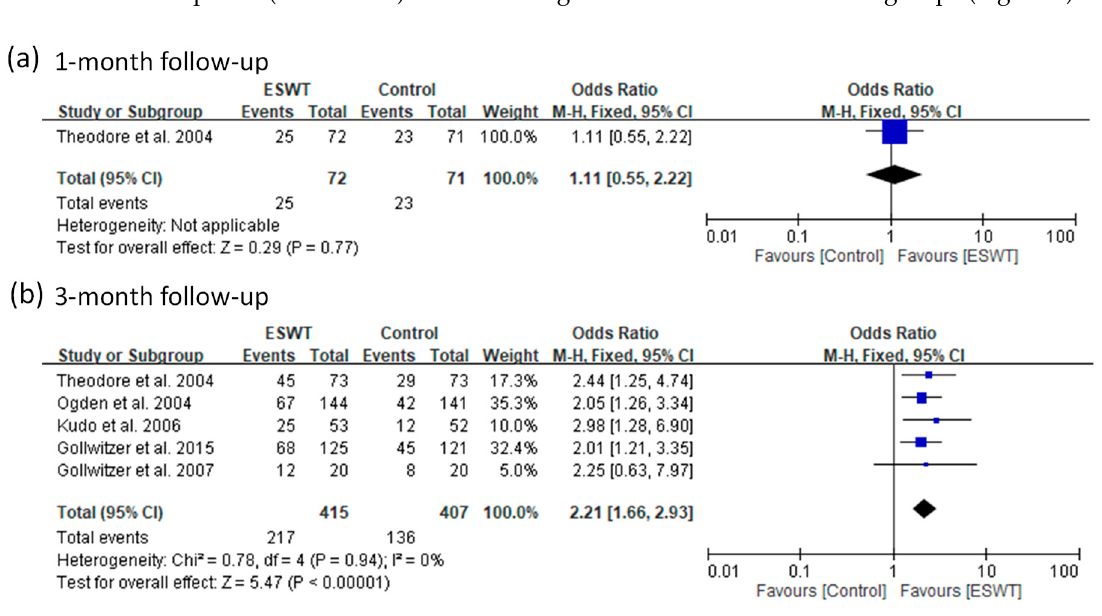
Figure 4. Forest plots of treatment success rates in high-energy extracorporeal shockwave therapy (ESWT) and placebo-controlled groups at 1-month ( a ) and 3-month ( b ) follow-ups. For the medium-energy group, four articles reported a success rate for three follow-up visits (3, 6, and 12 months). The ESWT group had a better success rate compared with the control group from three-month to 12-month follow-ups (fixed-e ff ect model, two trials, OR = 2.18, 95% CI = 1.39 to 3.43, p = 0.0007 at three-month; fixed-e ff ect model, two trials, OR = 2.82, 95% CI = 1.03 to 7.70, p = 0.04 at six-month; fixed-e ff ect model, two trials, OR = 2.31, 95% CI = 1.42 to 3.76, p = 0.0007 at 12-month) (Figure